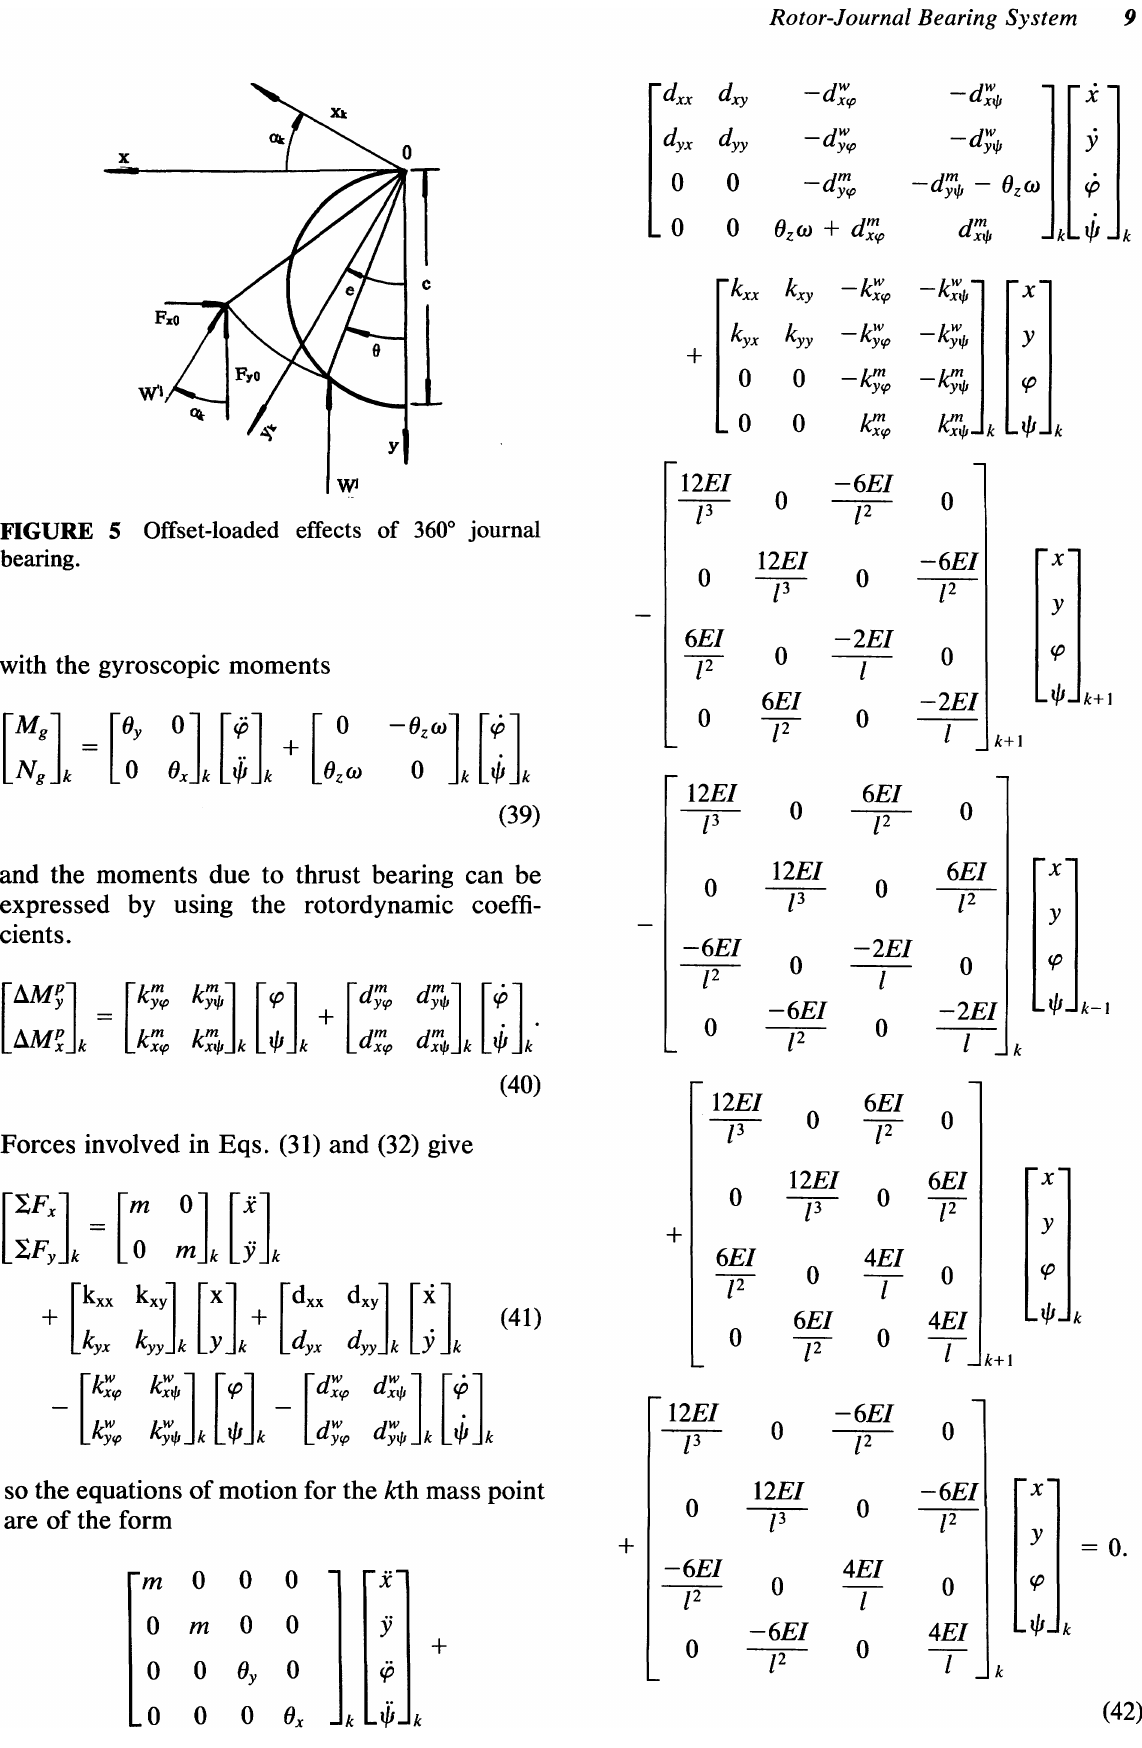
FIGURE 5 Offset-loaded effects of 360 0 journal